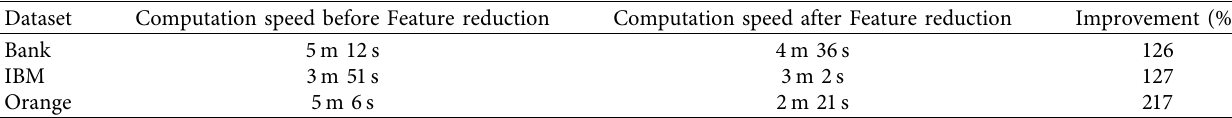
Table 8: Computational speed before and after feature reduction.